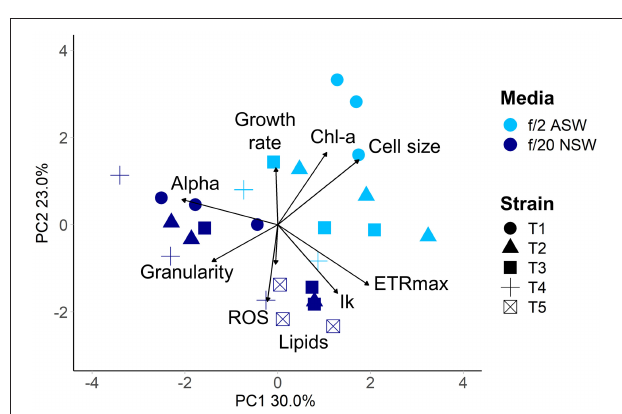
FIGURE 5 | Multivariate phenotypes of newly isolated centric diatom strains from Port Hacking IMOS National Reference Station visualised using Principal Component Analysis. Strains were grown in either artificial seawater with f/2 nutrients (light blue), or natural seawater with f/20 nutrients (dark blue) at 18 ◦ C with a 12:12 light cycle (60–100 µ mol m − 2 s − 1 ). Strains are indicated by symbol. Strain T5 did not grow in artificial